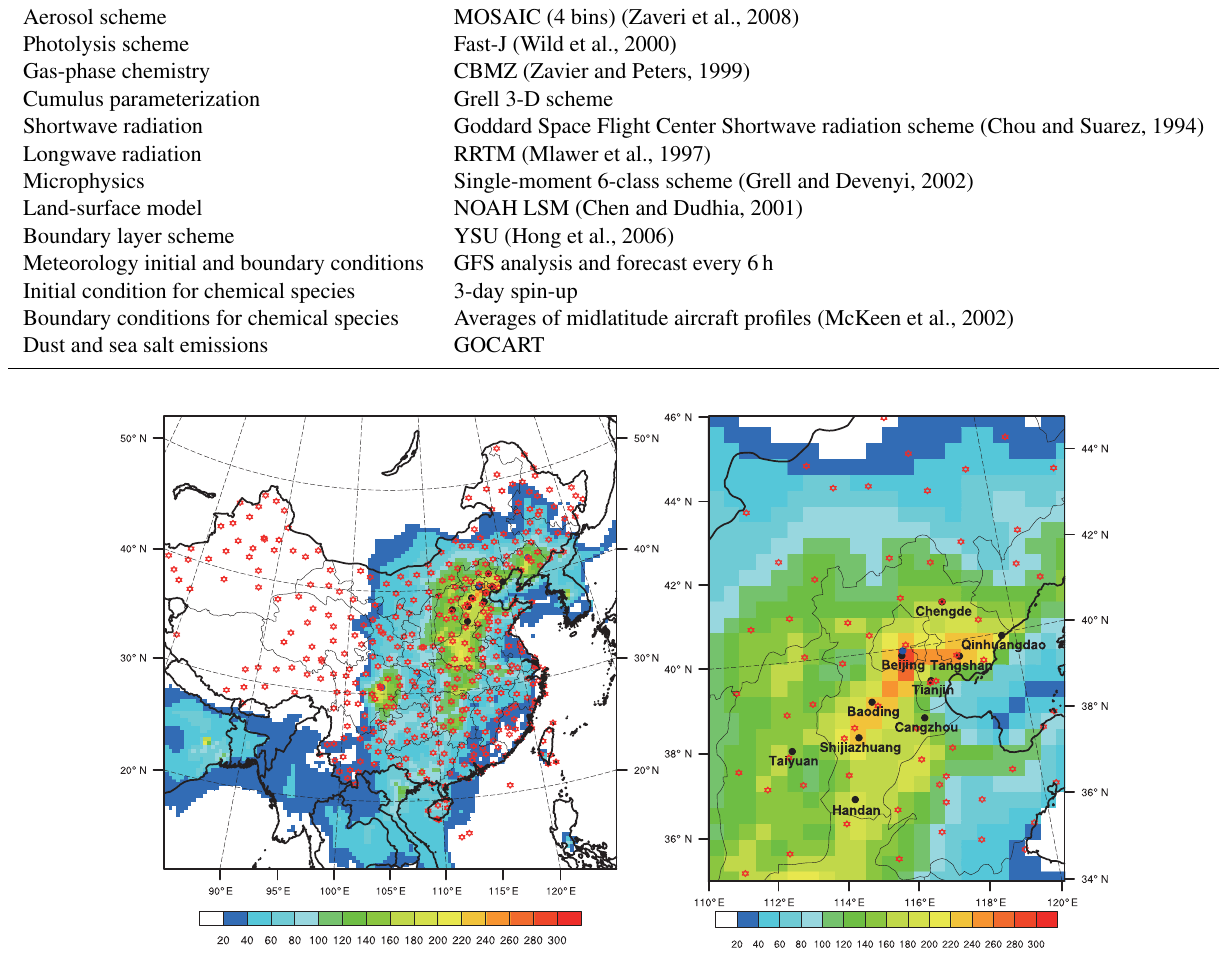
Figure 1. The model domain and (left panel) and the NCP (right panel). Dots are the observational sites, where red denotes NCDC meteoro- logical sites, blue denotes the Beijing Normal University (BNU) site, black denotes AQI national monitoring sites. Shaded backgrounds are model-simulated PM 2 . 5 concentrations (µgm − 3 ) that illustrate the regional pollution on 10